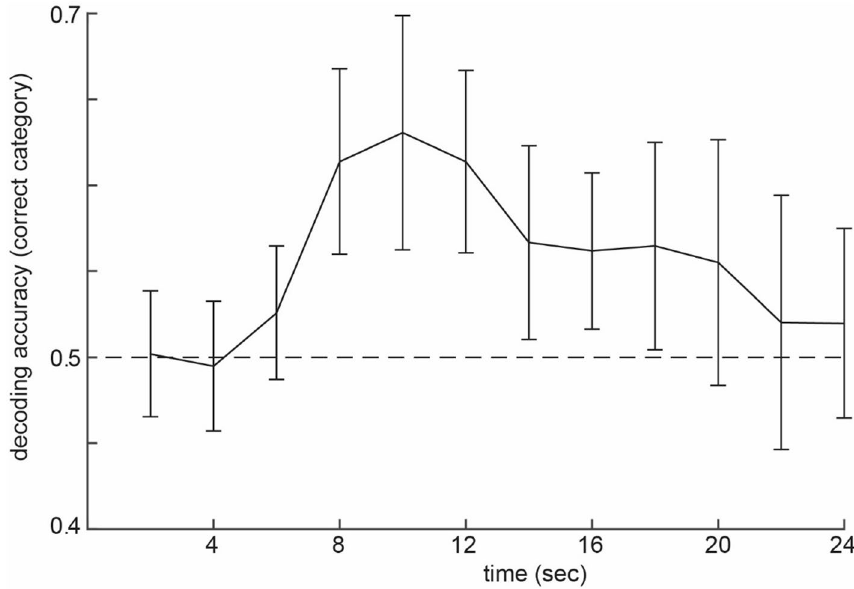
Figure 3. Group average of the decoding evidence during the test phase of the pilot experiment. Decoding evidence (group average ± SEM) of the correct category (0.5 is chance level, indicated by the dashed line). The object is presented on the screen the first 2